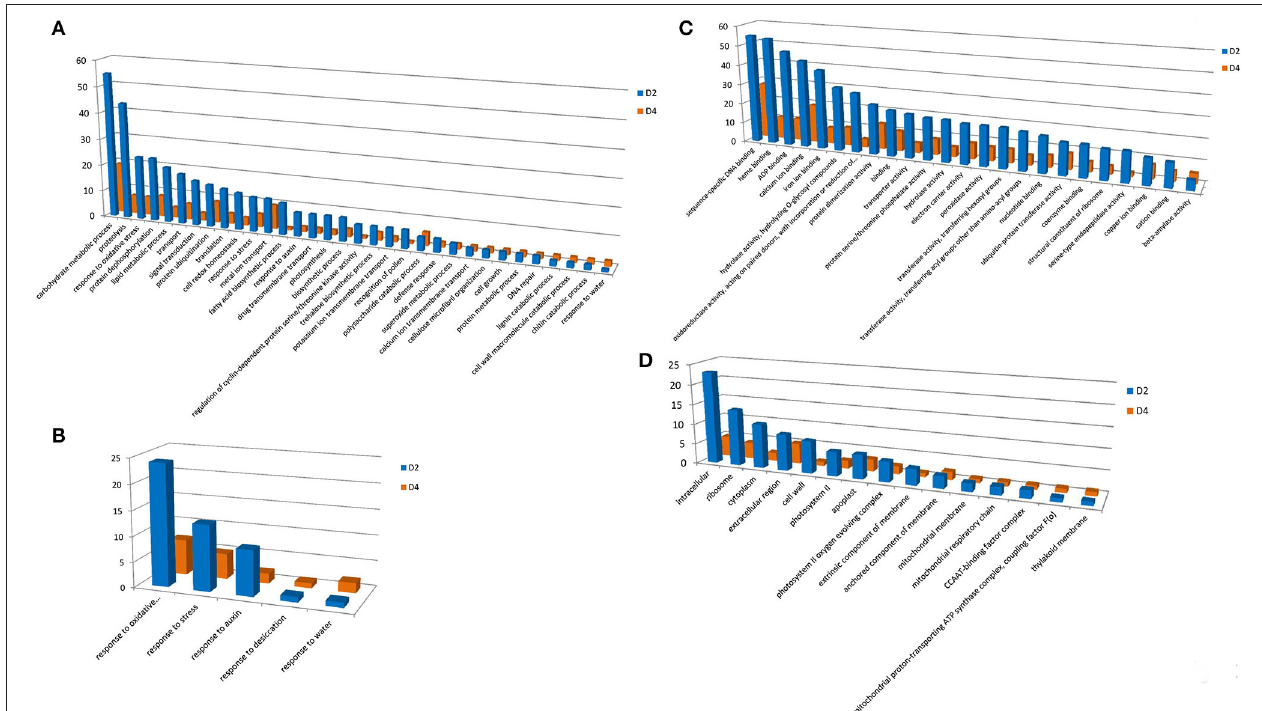
FIGURE 3 | Gene ontology terms with predominant DEG number under cold treatment. GO terms of BP (A) , MF (C) , and CC (D) were shown. (B) Indicates GO terms of MF, which are closely related to stress responses. Y-axis indicated the DEG number assigned in a GO term. CK, control; D2 and D4 indicated 2h and 4h of cold treatment,